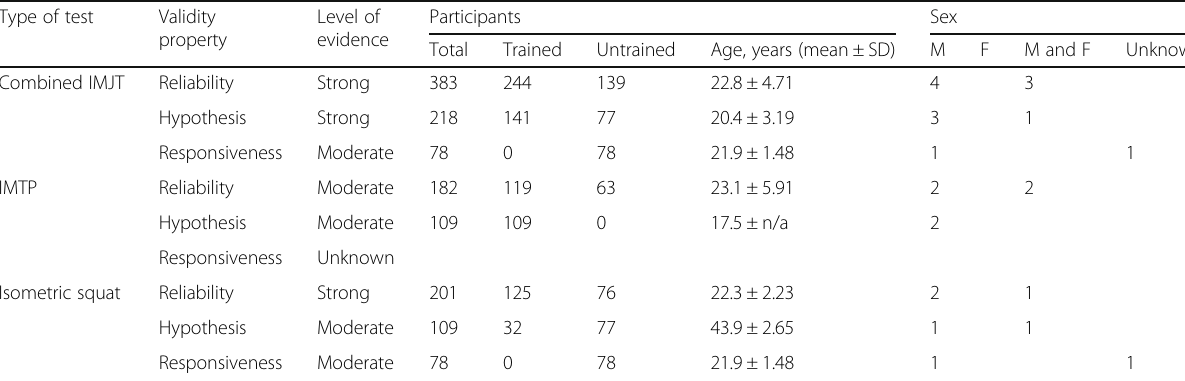
Table 2 Summary of best evidence synthesis